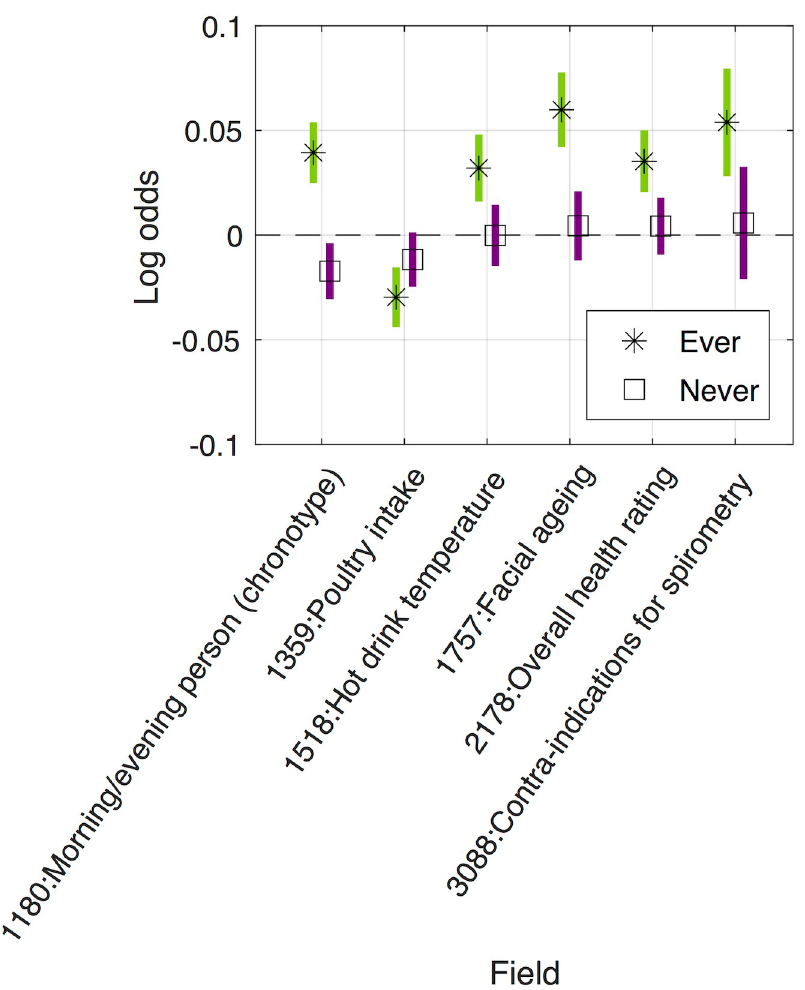
Fig 5. Identified main effects from MR-pheWAS in ever smokers, for ordered categorical outcomes. Results shown are those identified after correcting for multiple testing. 6 of 12 ordered categorical results are shown in this figure, with PHESANT ordered categorical result for never smokers. Results not shown in this figure are predominantly relevant to smoking participants only, e.g. “number of cigarettes smoked previously” such that they are absent in the never smokers (see S3 Table for further